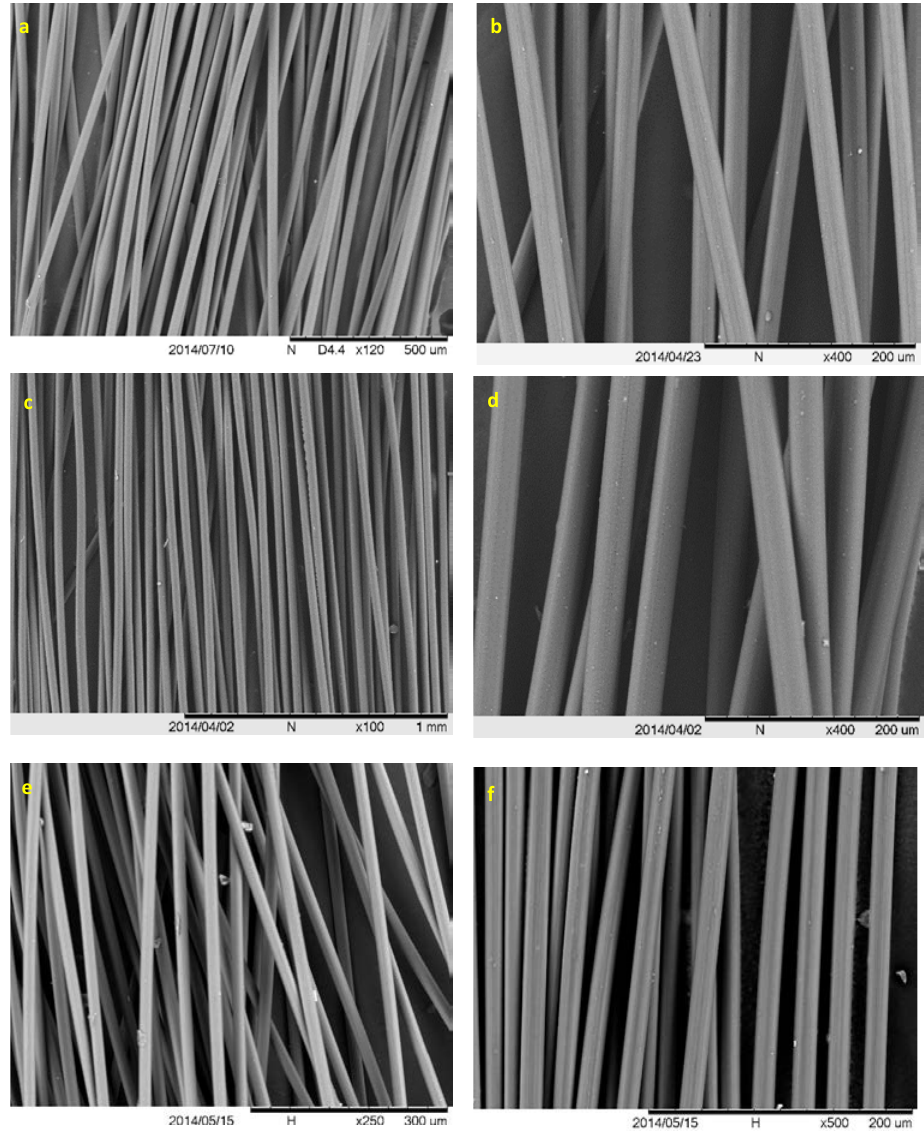
Figure 4. SEM images of carbon fibers made from switchgrass and yellow poplar lignin blends: ( a , b ) 50% YP:50% SG thermostabilized at heating rate of 0.05 °C min − 1 , ( c , d ) 50% YP:50% SG thermostabilized at heating rate of 0.5 °C min − 1 , ( e ) 75% YP:25% SG thermostabilized at heating rate of 0.05 °C min − 1 , and ( f ) 85% YP:15% SG thermostabilized at heating rate of 0.05 °C min − 1 .